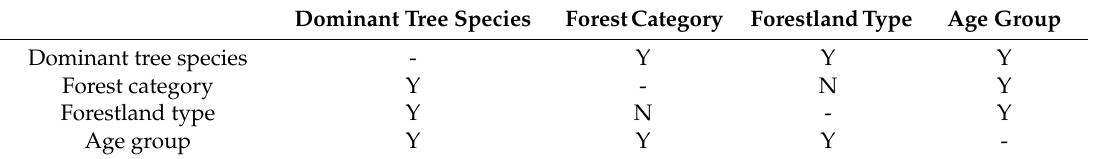
Table 4. Significant di ff erences in reflecting forest aboveground biomass among influencing